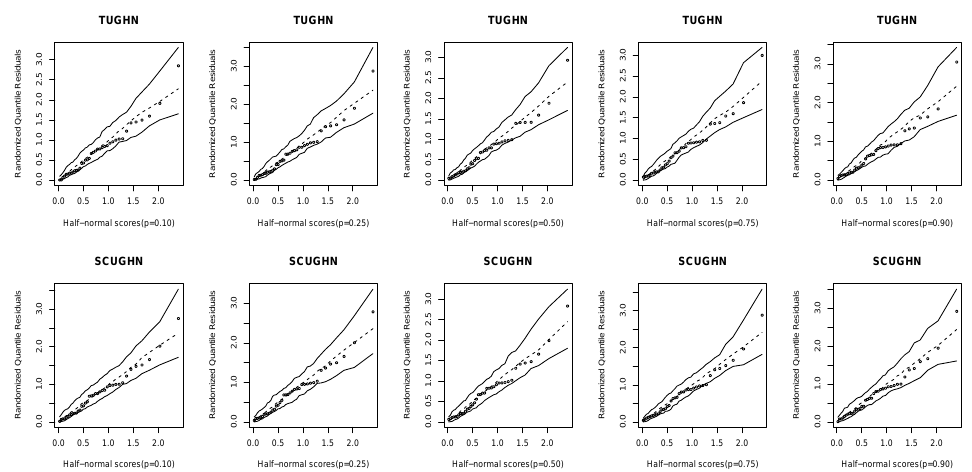
Figure 9. Half-normal plots of randomized quantile residuals of the TUGHN and SCUGHN regres- sion